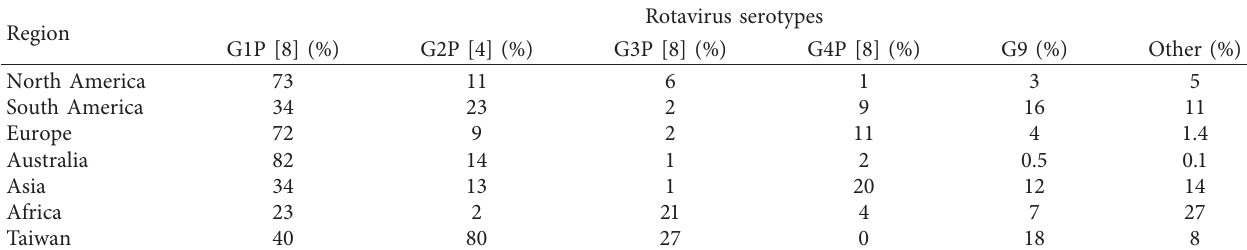
Table 4: Geographic distribution of rotavirus serotypes.